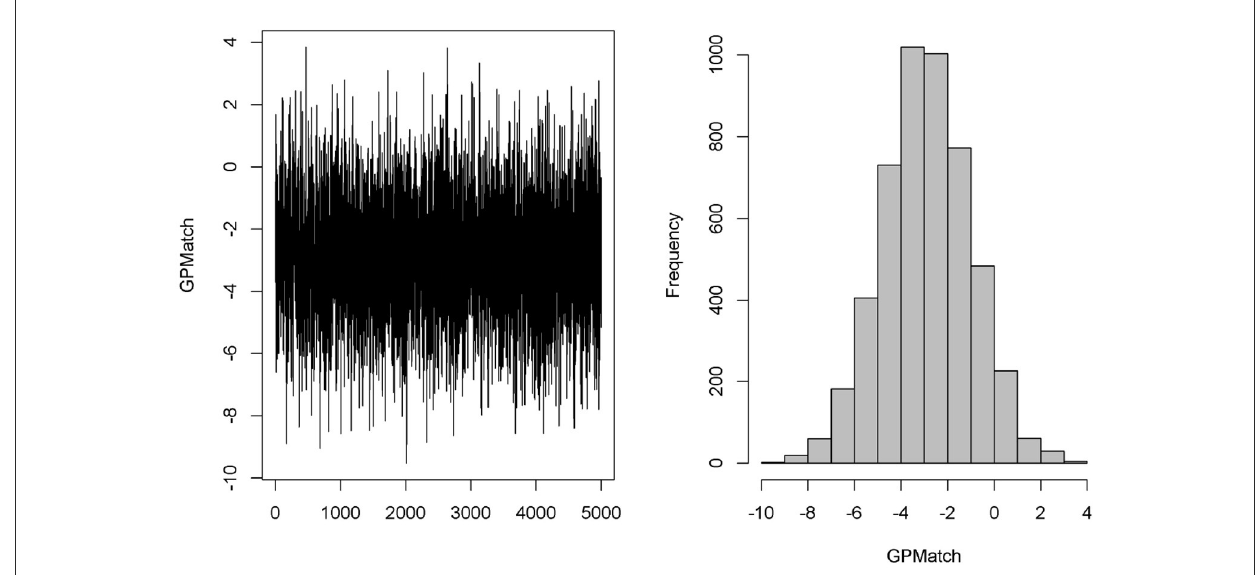
FIGURE7 Case study trace plot and histogram.